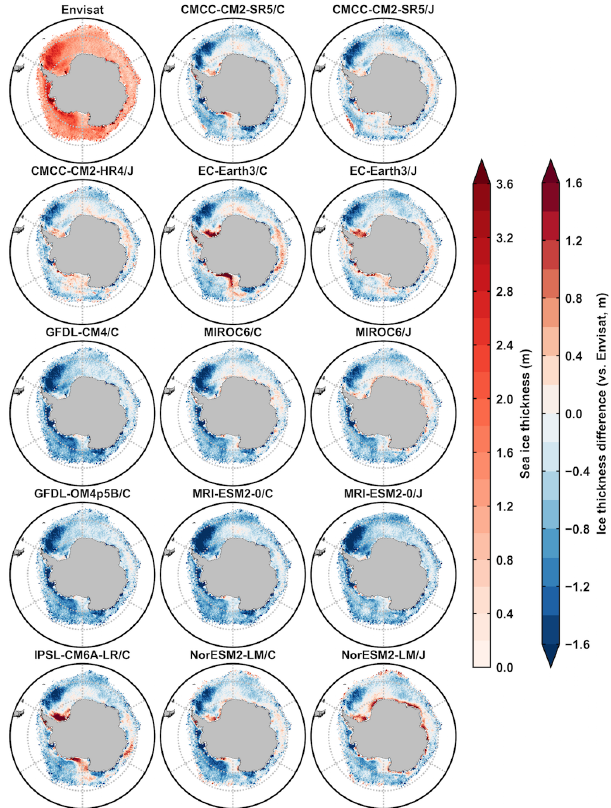
Figure A6. The 2003–2007 September mean Antarctic ice thick- ness from Envisat data (first picture, m) and ice thickness differ- ences between model outputs and Envisat data (m). The second and third columns are from the five OMIP1 and OMIP2 model outputs of CMCC-CM2-SR5, EC-Earth3, MIROC6, MRI-ESM2-0, and NorESM2-LM,